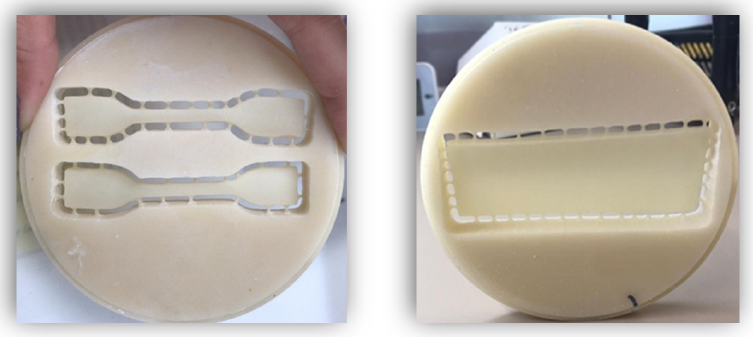
Figure 5. CAD/CAM Figure 5. CAD/CAM samples. Figure 5. CAD/CAM samples.